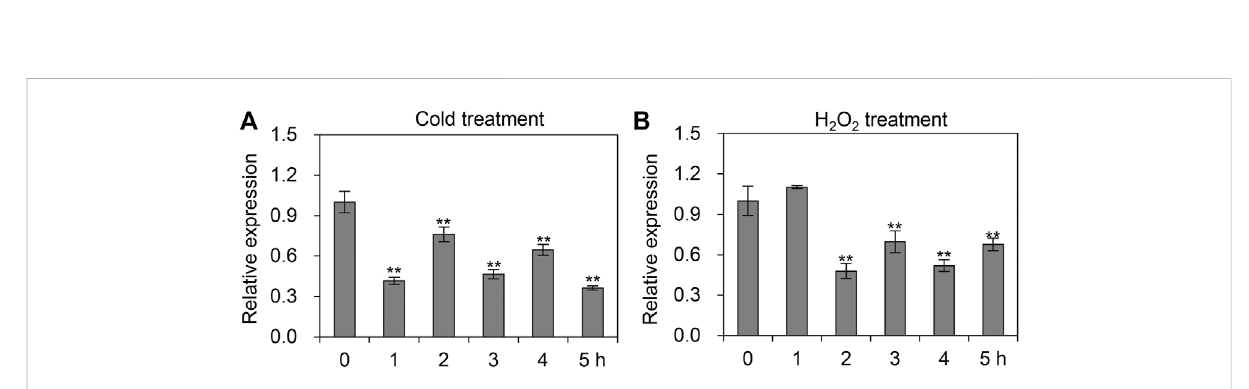
FIGURE 6 mRNAlevelsof AccTid undercold (A) andH 2 O 2 (B) .qRT – PCRwasusedtomeasurethemRNAlevelof Tid when A.cerana wassubjectedtocold and H 2 O 2 stresses. The internal control is β -actin , and * p < .05 and ** p < .01 suggest signi fi cant difference according to Bonferroni ’ s